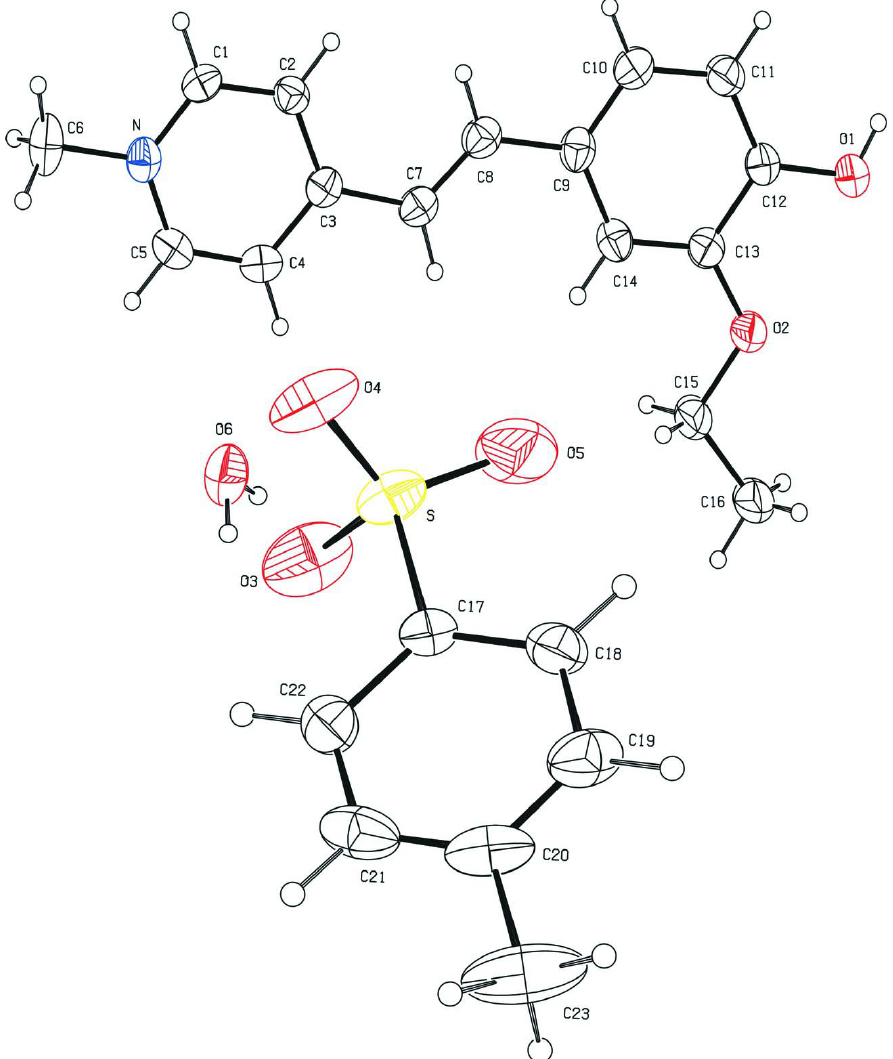
Figure 1 The molecular structure of title compound showing 30% probability displacement